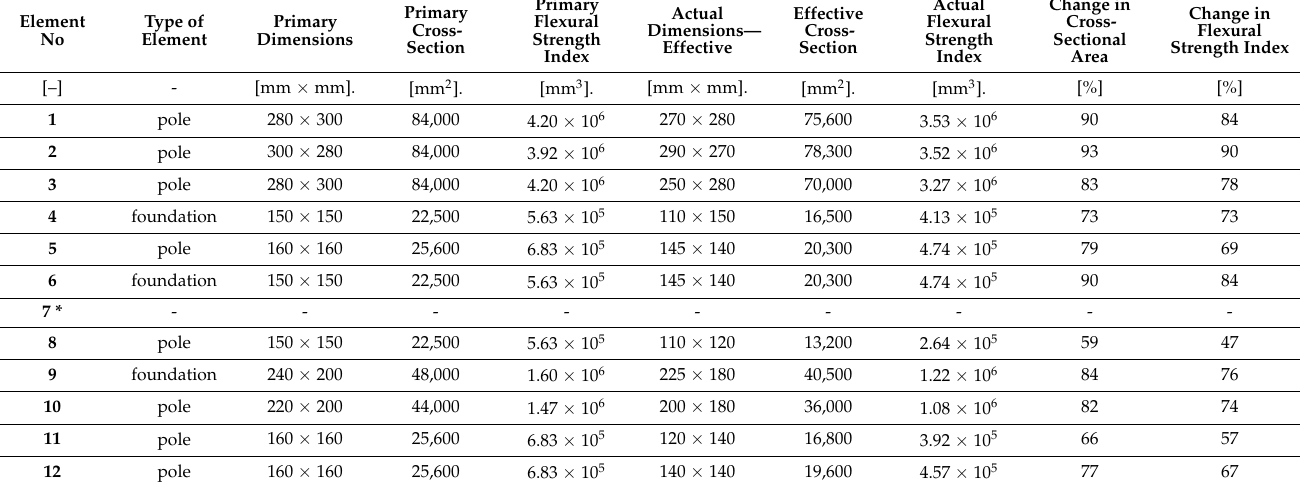
Table 2. Original and real—effective dimensions of wooden elements, changes of cross-sectional area, and bending strength index. Element Type of No